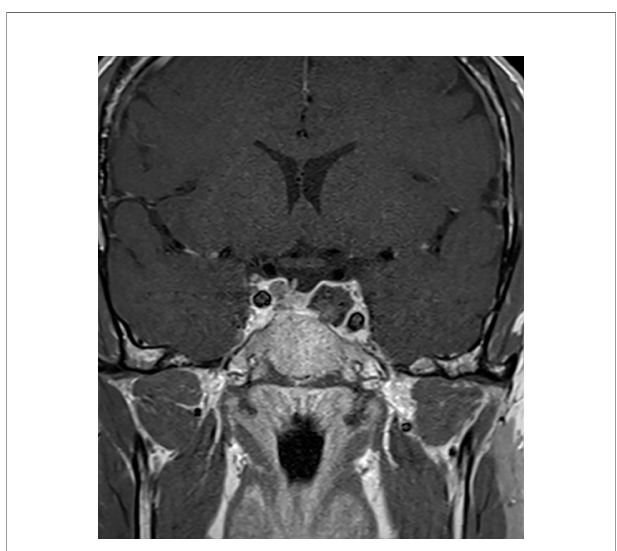
FIGURE 3 | Post-operative MRI. Sagittal MR Imaging T1 with Gadolinium showed a total resection of the pituitary